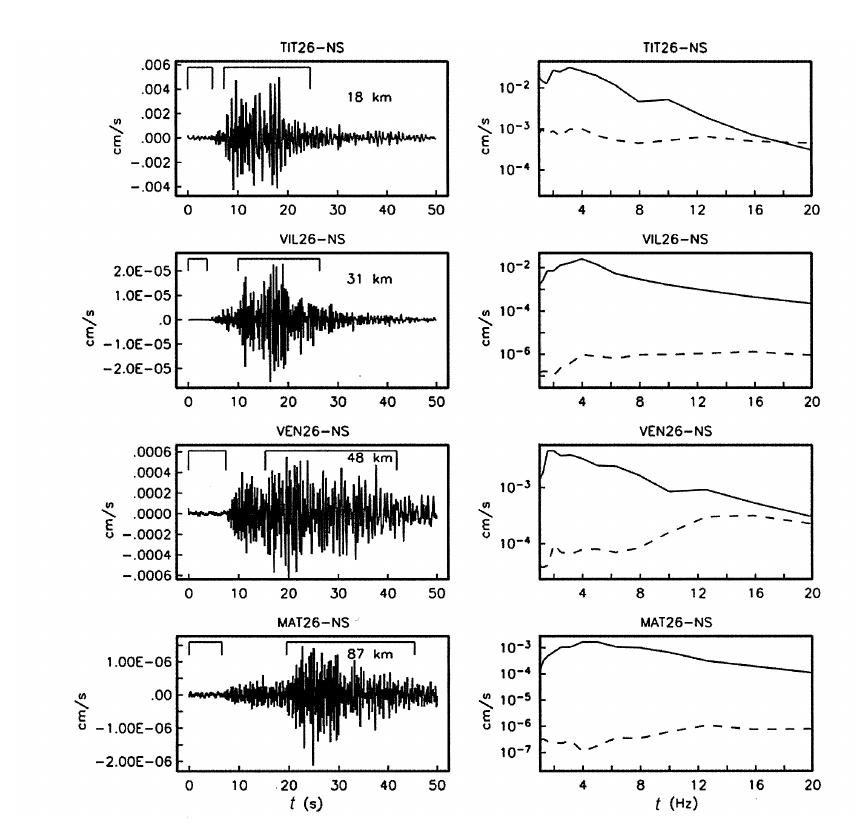
Fig. 4. The frames on the left show the velocity records from event 26 as recorded for the four stations used. The time series are order from minimum distance (top frame) to maximum hypocentral distance. It is also shown the window use to calculate the Fourier transform. The frames on the right are the corresponding acceleration spectra of the S -wave signal (solid line) and the pre-event noise (dashed